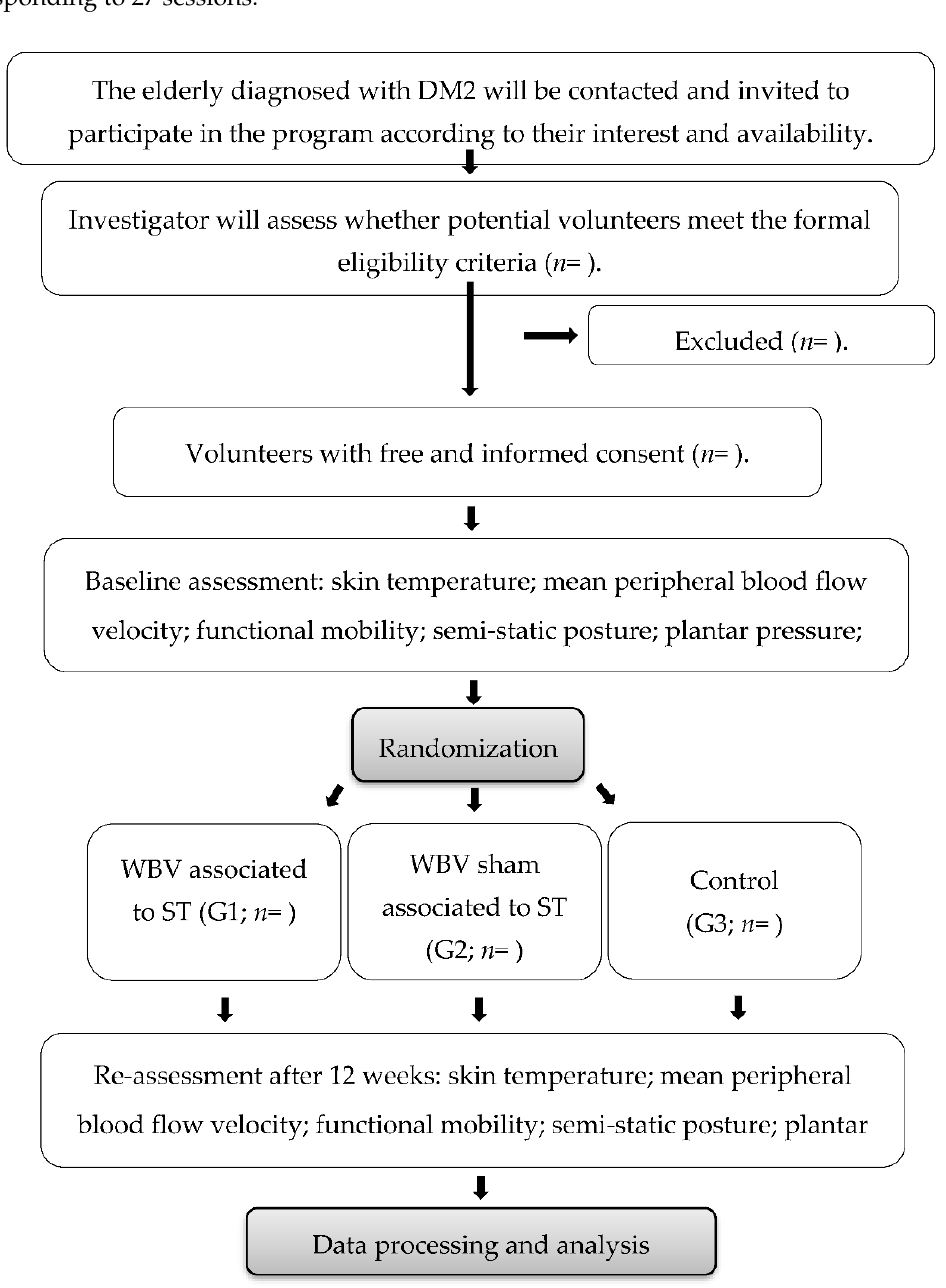
Figure 1. Enrollment, randomization and assessment flow chart. DM2, type 2 diabetes; WBV, whole- body vibration; ST, strength